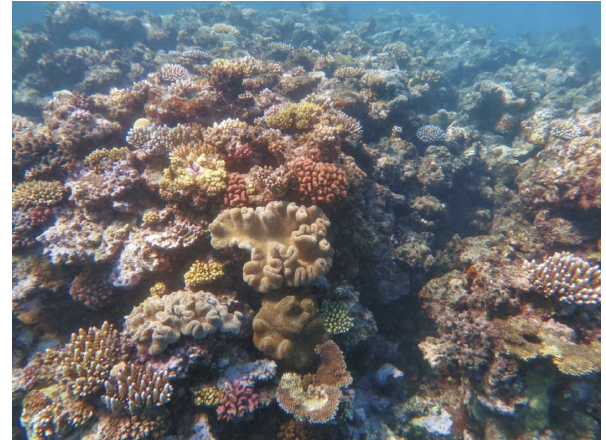
Figure 2. Diversity of corals at Norman Reef in the northern Great Barrier Reef, Australia (R.